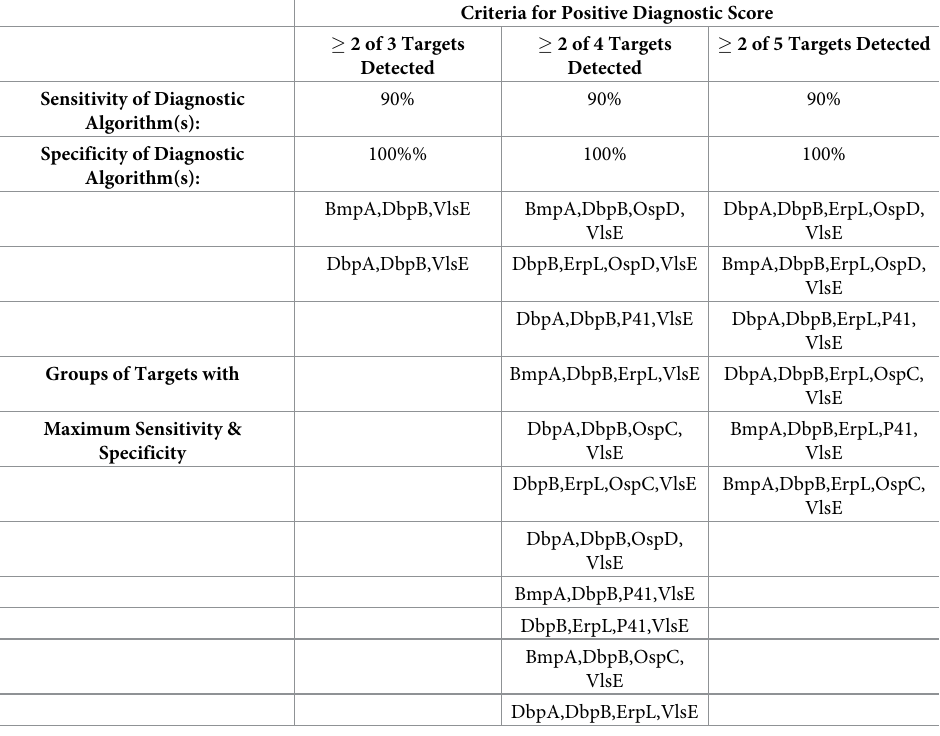
Table 3. Optimal diagnostic algorithms using combinations of highly predictive antigen targets. Combinations of 3, 4, or 5 targets, in which detection of at least 2 targets scores positive for the infection, have been found to identify Lyme(+) and Lyme(-) samples with high sensitivity and specificity. The diagnostic algorithms with the highest com- bined sensitivity and specificity values are listed. Criteria for Positive Diagnostic Score � 2 of 3 Targets